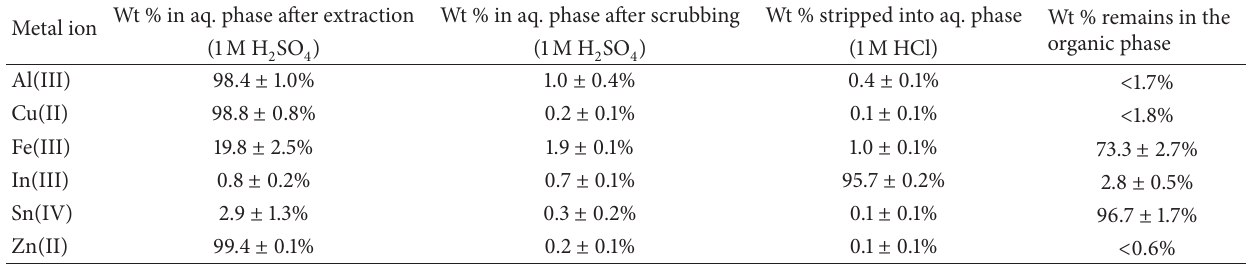
SO (extraction and scrubbing) and 1M 2 4